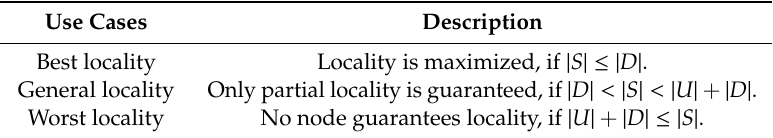
Table 1. Three use cases for DSPE applications classified by the locality.